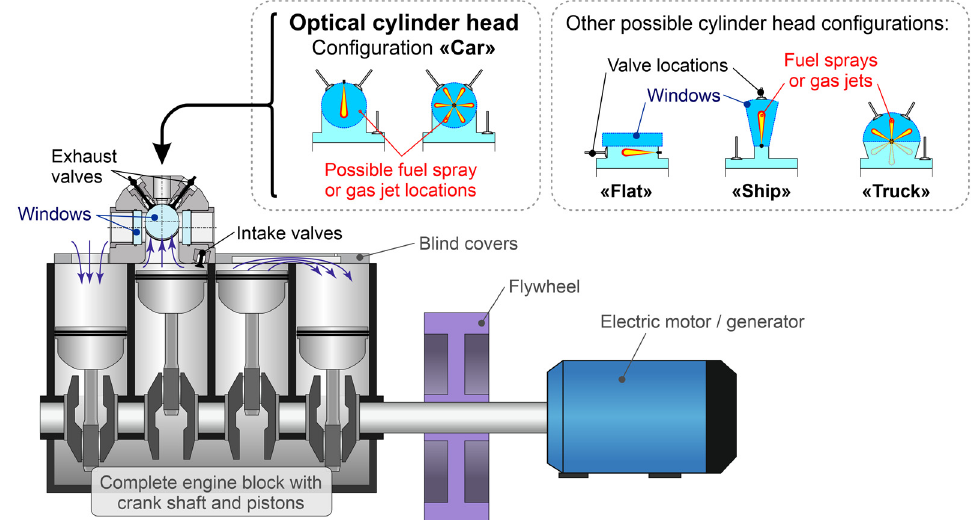
Figure 3. Sketch of the new test rig and possible optical cylinder head configurations (named according to the observable fuel spray / gas jet length “class”). The “car” type cylinder head has been realized initially.